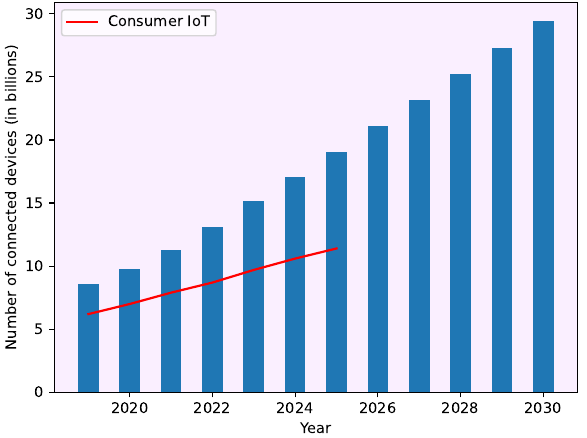
Figure 1. IoT demand